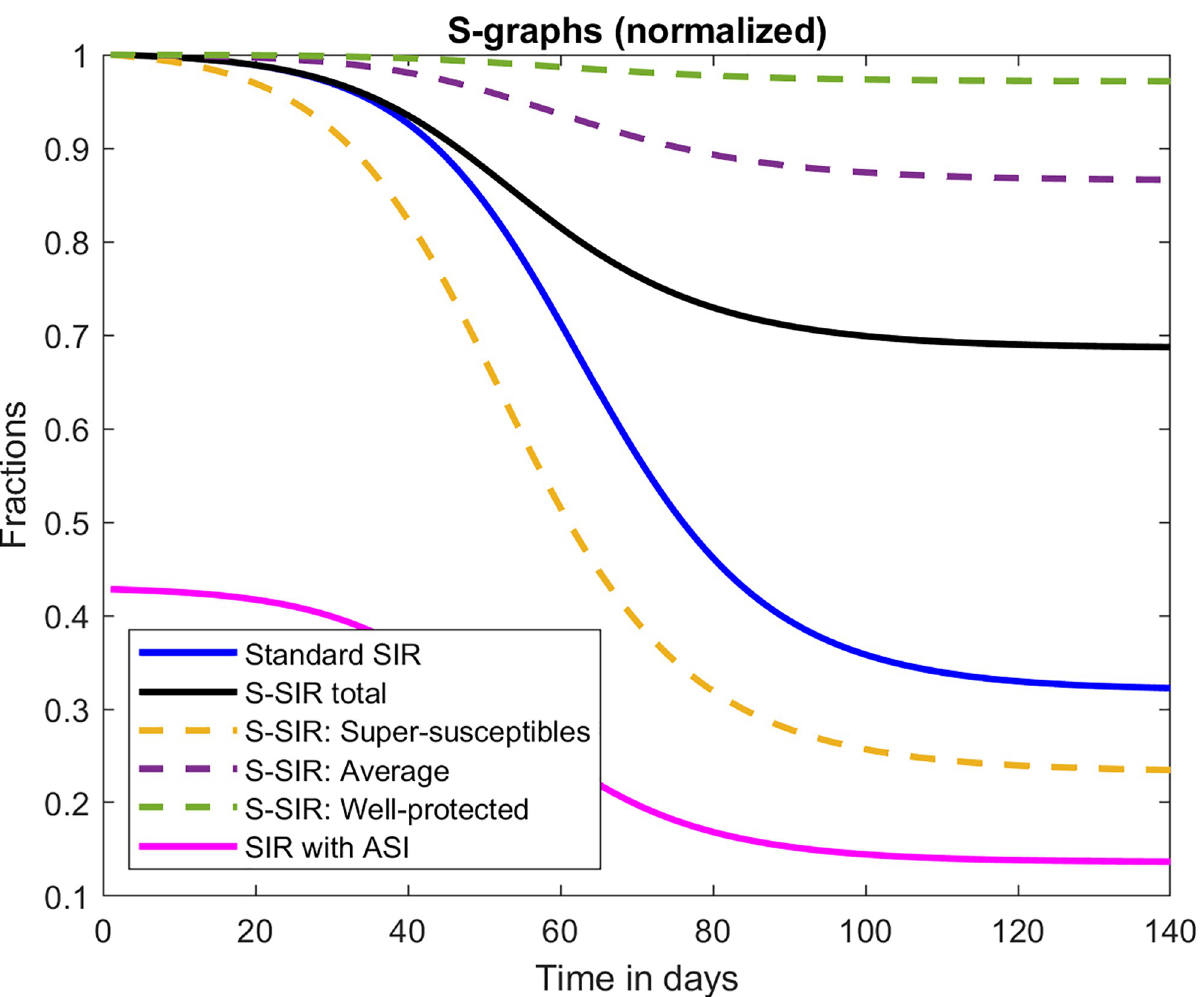
Fig 2. Graphs of susceptibles S . S –curves corresponding to the 3 graphs in Fig 1. As in Fig 1, the blue black and pink have been normalized by division by N . The black curve thus shows the proportion of the total population susceptible to the virus. Note that when the pandemic is over, around 68% are still susceptible, in stark contrast to classical SIR which levels out at around 34%. The pink curve starts out assuming 57% have artificial sterilizing immunity, and hence its initial value is 43% (this number was chosen using the formula (8)). Note that the pink curve looks exactly like the black except for a vertical translation, illustrating the key findings of this article. The S-SIR model has three subgroups S 1 , S 2 , S 3 corresponding to p 1 = 1 (labeled “super-susceptibles”), p 2 = 0.1 (labeled “normal”) and p 3 = 0.02 (labeled “well-protected”). Here we have normalized with the amount of people in each respective subgroup, wherefore all curves start at 1. Note how the spread in the latter two sub-groups level out as soon as it levels out in the super- susceptible